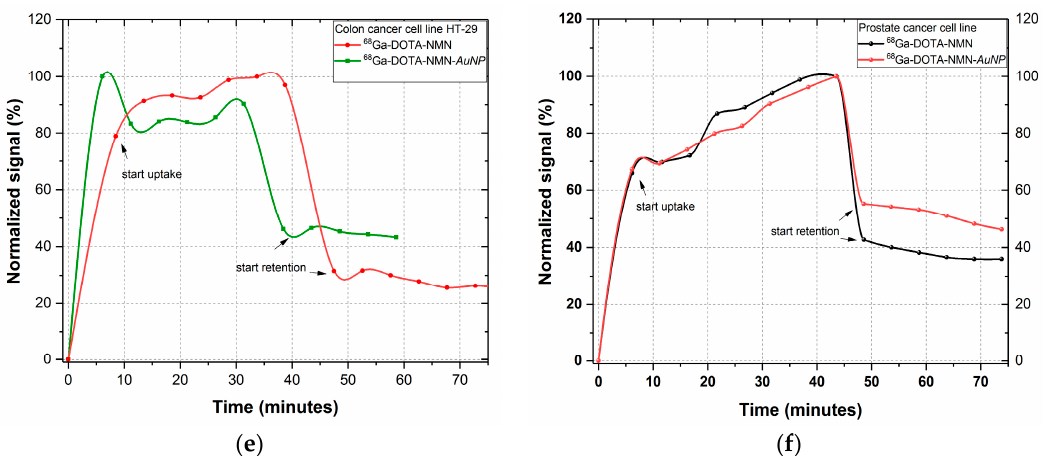
Figure 3. In vitro comparative uptake and retention of: ( a ) 68 Ga ‐ DOTA ‐ PEG(4) ‐ BBN(7 ‐ 14) and 68 Ga ‐ DOTA ‐ PEG(4) ‐ BBN(7 ‐ 14) ‐ AuNP on HT ‐ 29 cell line; ( b ) 68 Ga ‐ DOTA ‐ PEG(4) ‐ BBN(7 ‐ 14) and 68 Ga ‐ DOTA ‐ PEG(4) ‐ BBN(7 ‐ 14) ‐ AuNP on DU ‐ 145 cell line; ( c ) 68 Ga ‐ DOTA ‐ NMB and 68 Ga ‐ DOTA ‐ NMB ‐ AuNP on HT ‐ 29 cell line; ( d ) 68 Ga ‐ DOTA ‐ NMB and 68 Ga ‐ DOTA ‐ NMB ‐ AuNP on DU ‐ 145 cell line; ( e ) 68 Ga ‐ DOTA ‐ NMN and 68 Ga ‐ DOTA ‐ NMN ‐ AuNP on HT ‐ 29 cell line; ( f ) 68 Ga ‐ DOTA ‐ NMN and 68 Ga ‐ DOTA ‐ NMN ‐ AuNP on DU ‐ 145 cell line.